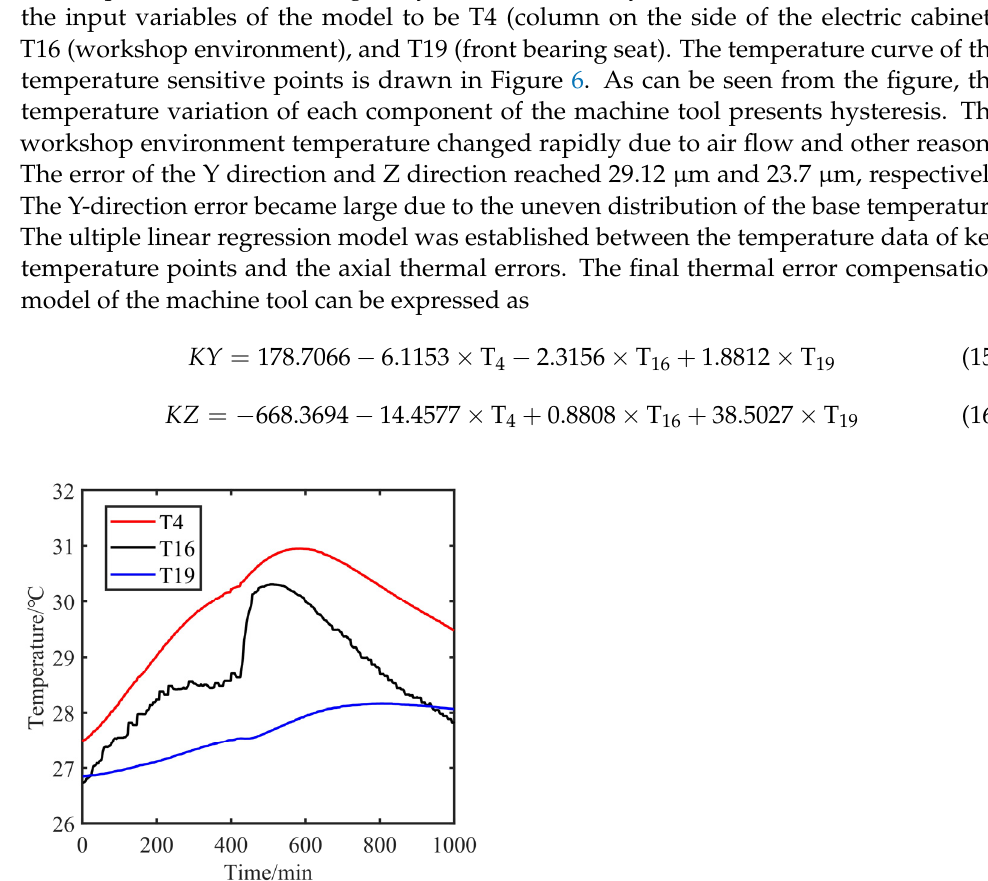
( b ) Z-direction thermal error data Figure 7. The fitting results and residual error for the second machine tool. 5. Conclusions This paper mainly proposed a thermal error modeling method based on improved FCM cluster analysis and F-test statistics, which greatly reduced the temperature meas- urement data. The following conclusions can be drawn: